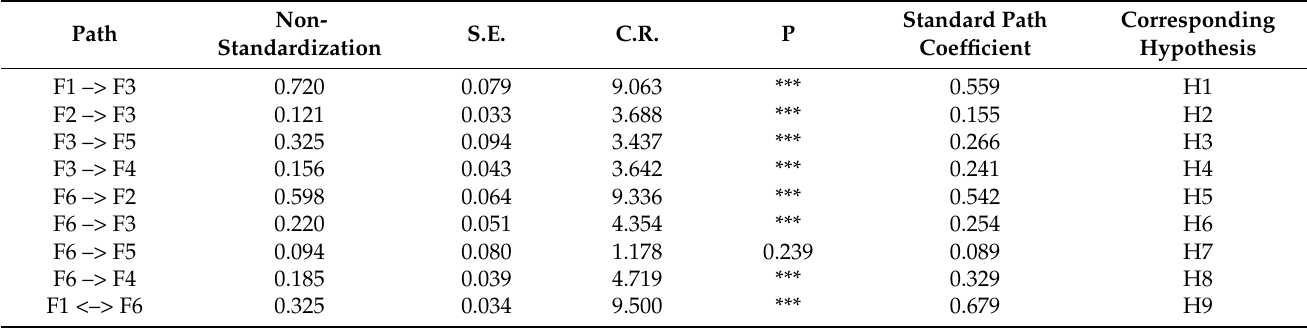
Table 8. Path coefficients and their significance tests.